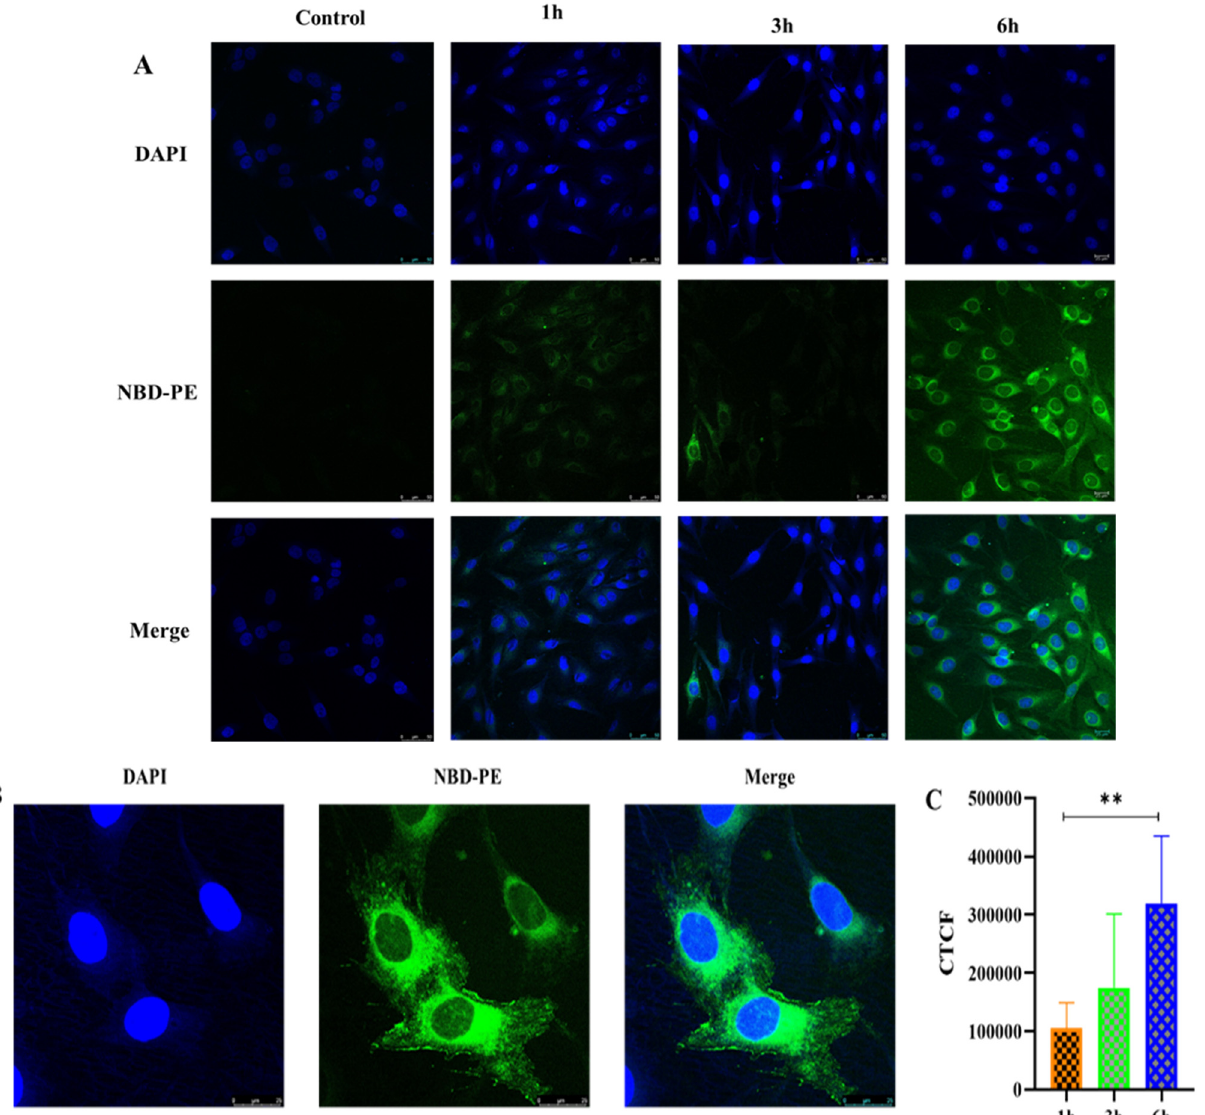
Figure 10. Cellular uptake in MG-63 cells incubated with fluorescent PTH-LPs. ( A ) Confocal micro- scopic images for time-dependent cellular uptake study (scale bar 50 µ m), ( B ) Cellular uptake at 6 h (scale bar 25 µ m), ( C ) Corrected Total Cell Fluorescence (CTCF) after treatment of PTH-LPs at 1 h, 3 h, and 6 h. ** p <